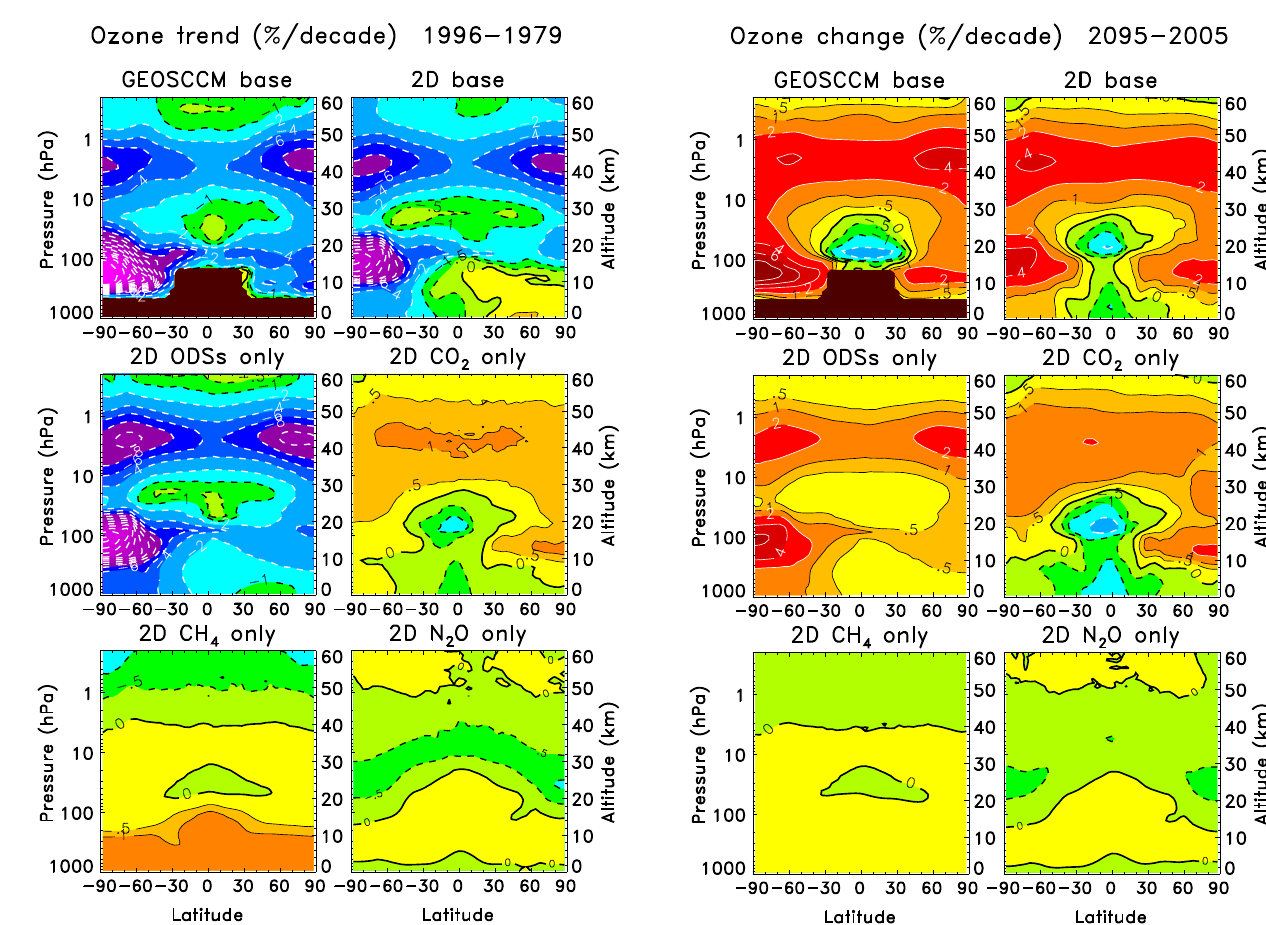
Fig. 3. Annually averaged ozone trend for 1996–1979 derived from the GEOSCCM and 2-D model simulations. The top panels are from the base simulations in which all source gases are varied time dependently. The middle and bottom panels show 2-D simulations in which only the ODSs or GHGs are varied time dependently as indicated. The trends are derived from regression fits to the EESC time series (Fig. 1) for 1979–2004. The GEOSCCM trends are not computed in the troposphere as ozone is relaxed to a climatology in this region. The contour intervals are ± 2 % decade − 1 and include the ± 5 and ± 1 % decade − 1 contours. The purple and blue colors indicate the largest negative values, and the orange and yellow colors indicate the largest positive values.